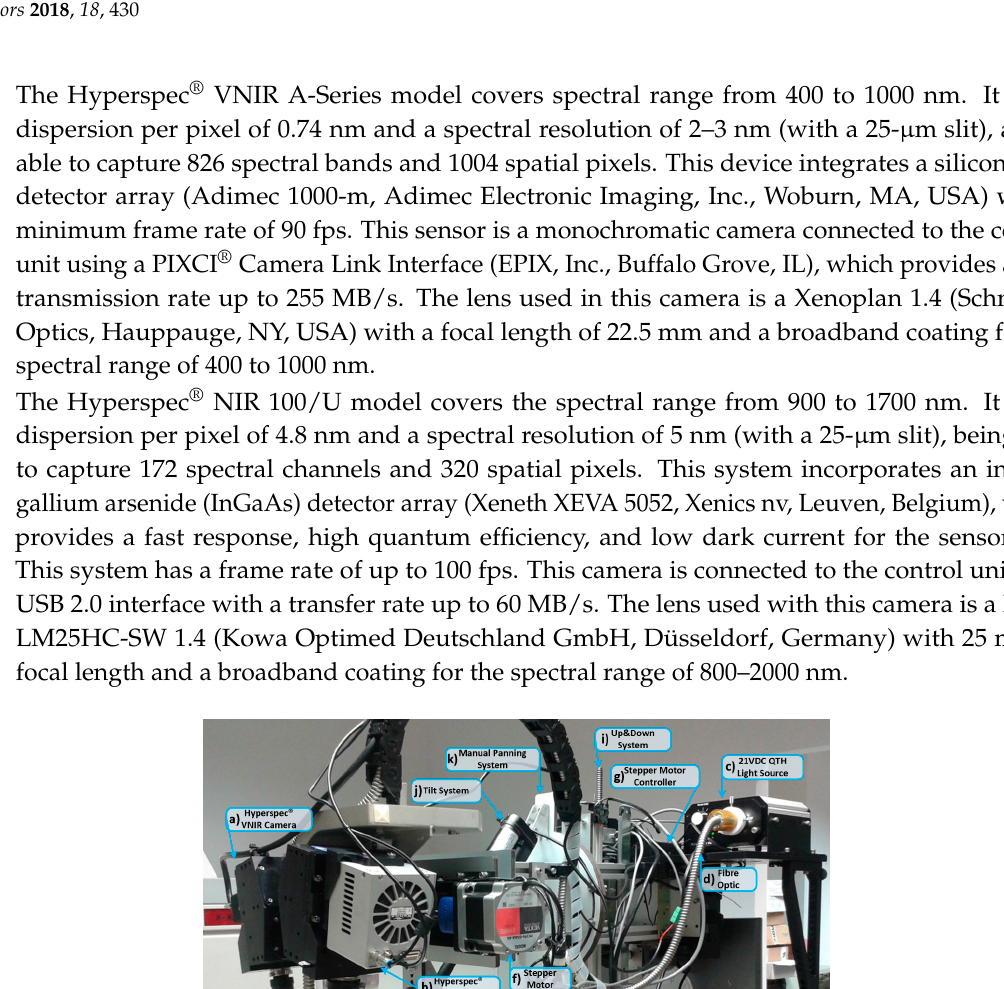
Figure 1. The HELICoiD demonstrator block diagram. QTH: Quartz Tungsten Halogen.